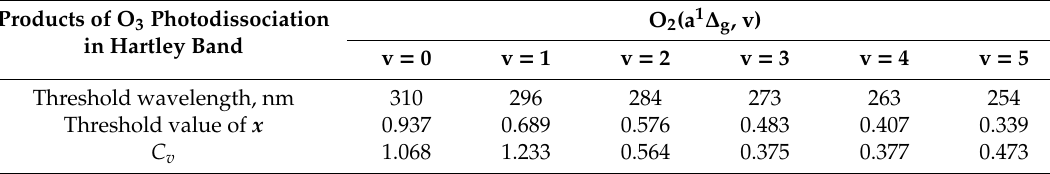
Table 1. Threshold wavelengths λ used to calculate threshold value of x and normalization factors C v .